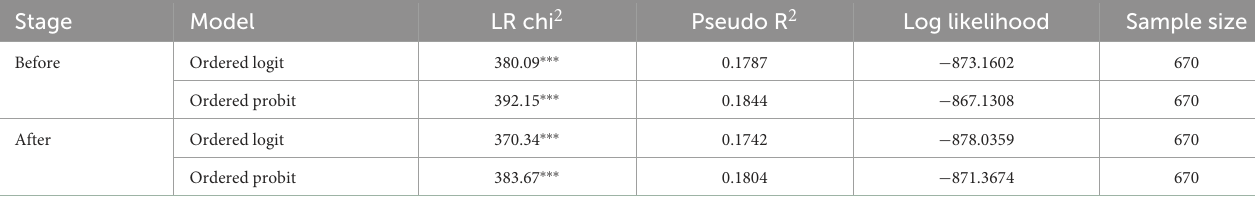
TABLE 3 Model fit of research